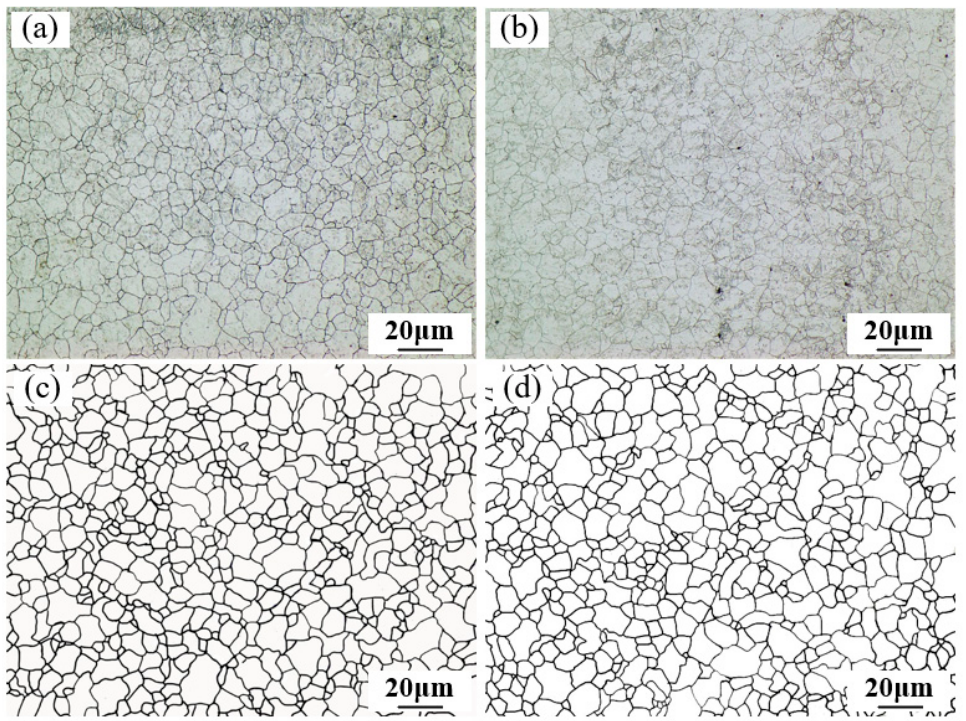
Figure 11. Original austenite grain size of S1 ( a , c ) and S2 ( b , d ), of which ( c , d ) depict austenite grain boundaries by the PS software for S1 and S2 sample, respectively.